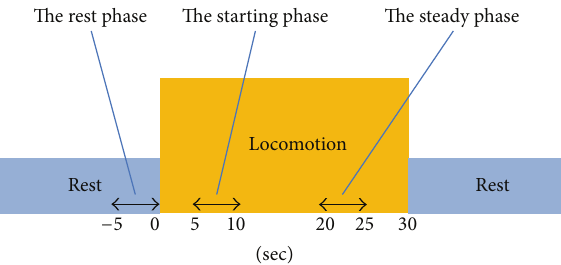
Figure 4: Three distinct phases used in the statistical